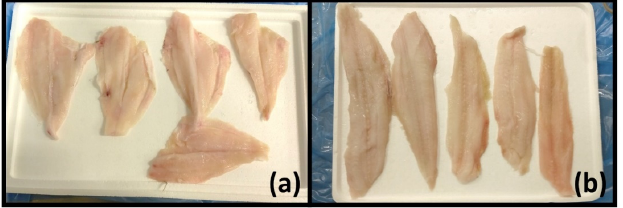
Figure 1. Fillets of ( a ) Guinean sole ( Synaptura cadenati ) and ( b ) European plaice ( Pleuronectes platessa ).